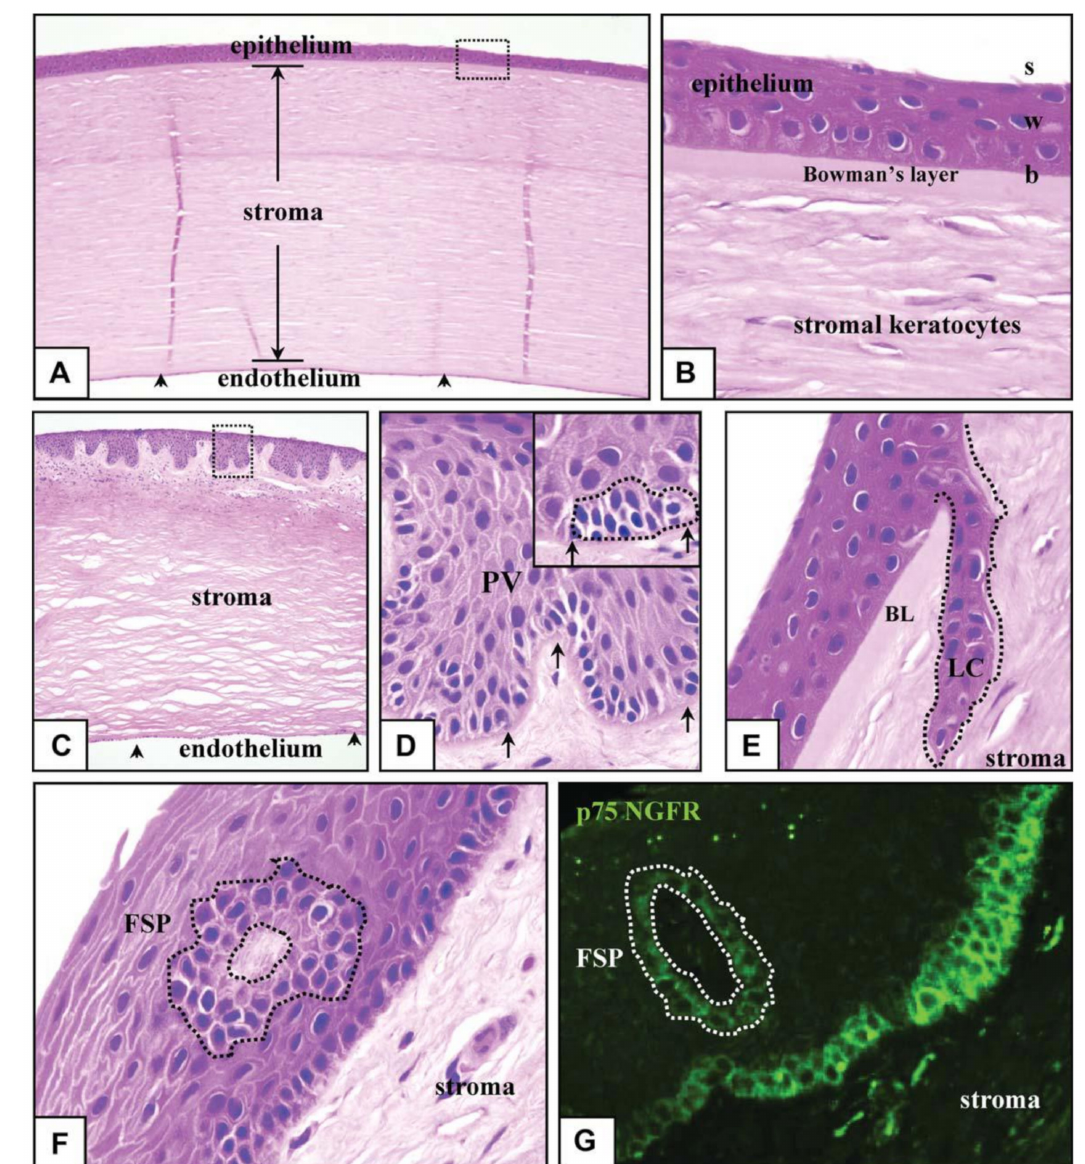
Figure 2. Human corneo-limbus pathologic characteristics. Entire human eye sections were segmented, stained with eosin and hematoxylin ( A – F ), as well as for the low-affinity NGFR (p75) ( G ), and visualized using normal ( A – F ) or fluorescence ( G ) microscopy. The middle cornea is made up of a multilayered epithelium of squames (s), basal (b) and wing (w) layers, a keratocyte including a monolayer and stroma with complex endothelial cells ( A , C , arrowheads). BL separates the corneal epithelium from the stroma ( B ). The limbus is distinguished by the PV ( C , D ), which contains bundles of small stem-like cells ( D ; inset, hatched line). LC ( E , hatched line) and FSP are two other newly discovered stem cell-harboring structures ( F , G , hatched lines). The limbal membrane is shown by the arrows in ( D ). The boxed region in ( C ) is magnified ( D ). Apart from ( A , C ) (100), and ( G ) (400), all pictures were taken with an optical microscope using oil (1000). BL stands for Bowman’s layer, FSP stands for focusing on PV stands, stromal projections, LC stands for limbal crypt and NGFR stands for nerve growth factor receptor for Palisades of